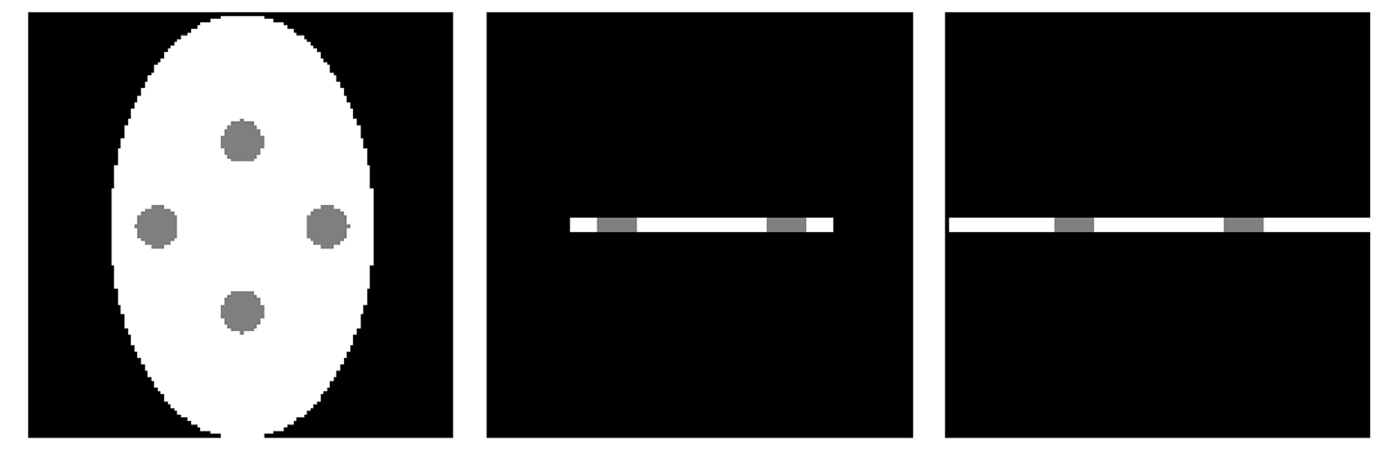
Fig 7. Tabular object phantom